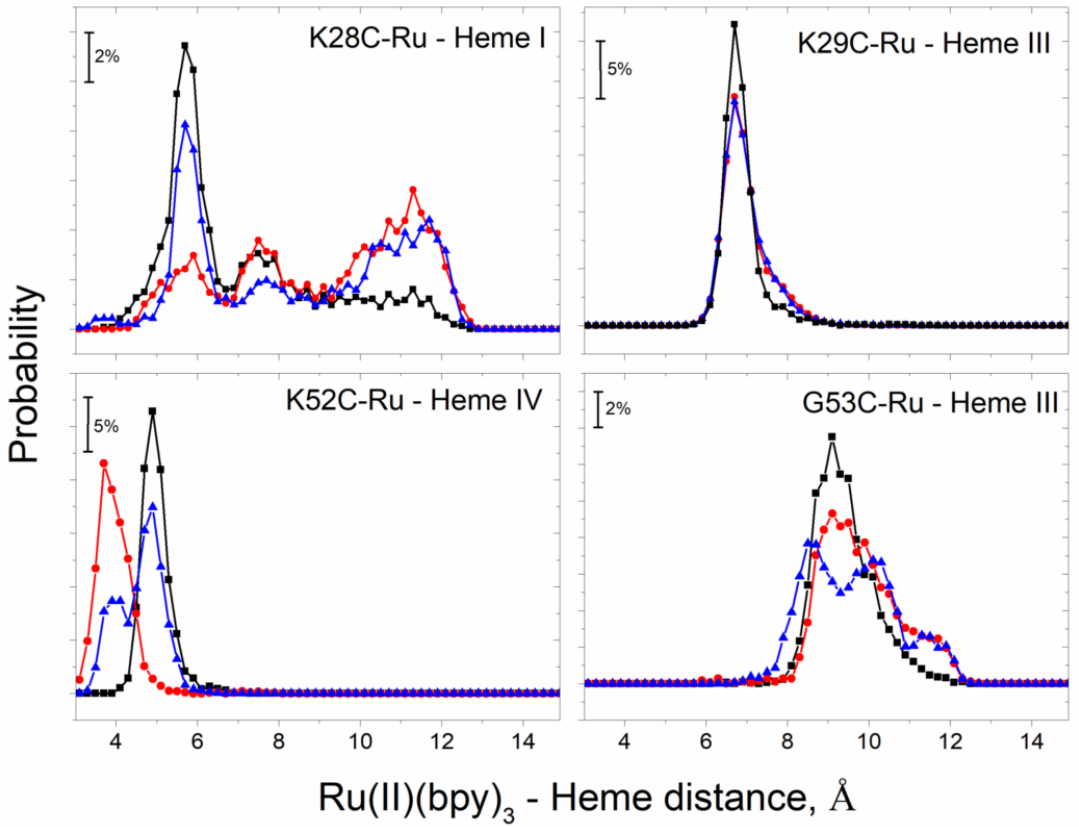
Figure 4. Distance distributions between aromatic atoms of photosensitizer and the closest PpcA hemes as observed in three independent (shown with different colors) ~300 ns each all-atom molecular dynamics simulations (each simulation shown with different colors). Frequencies (in %) were calculated for 0.2 Å distance intervals.